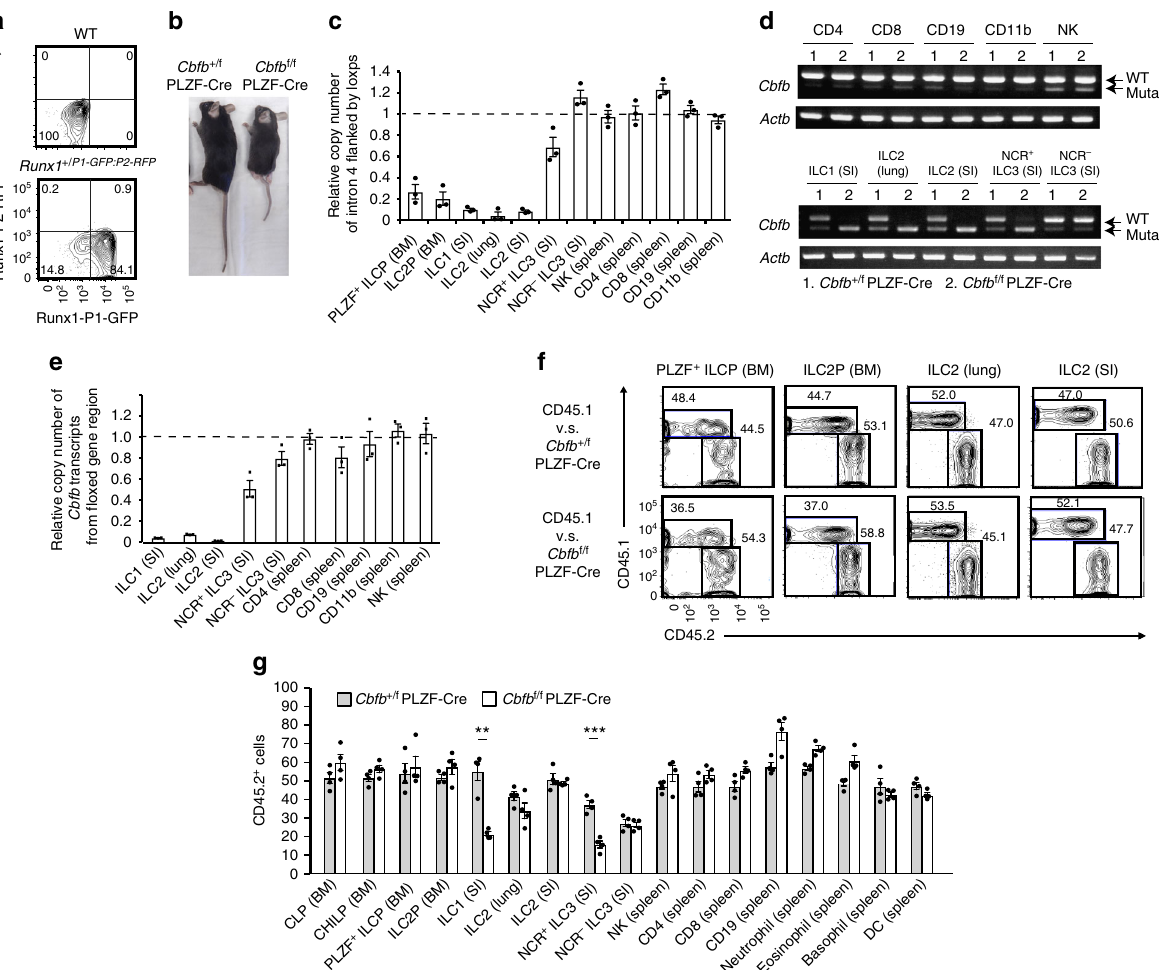
Fig. 1 Cbf β is not necessary for ILC2 differentiation. a Flow cytometry analysis of Runx1-GFP expression from the P1 promotor and Runx1-RFP from the P2 promotor by ILC2s (CD45 + CD3 – CD19 – CD127 + CD25 + ST2 + ) in the lungs of WT (top) and Runx1 + /P1-GFP: P2-RFP mice (bottom). b Gross appearance of the Cbfb + /f PLZF-Cre (left) and Cbfb f/f PLZF-Cre mice (right). c Quantitative PCR analysis of the relative copy numbers of the fl oxed genes (loxP site, loxps) located in Cbfb intron 4 compared to those of the un fl oxed genes in Cbfb intron 4 in the indicated cell populations of Cbfb f/f PLZF-Cre mice. d RT- PCR assay of Cbfb transcripts with or without a mutation in the indicated cell populations of the Cbfb + /f PLZF-Cre (1) and Cbfb f/f PLZF-Cre mice (2). e Quantitative PCR analysis of the relative copy numbers of Cbfb transcripts from the fl oxed Cbfb gene locus in the indicated cell populations of Cbfb f/f PLZF-Cre mice. f , g Chimerism of common lymphoid progenitor (CLP: CD45 + Lin – cKit lo CD127 + sca1 lo Flt3 + α 4 β 7 – ), CHILP (CD45 + Lin – CD127 + α 4 β 7 + Flt3 – CD25 – ), PLZF + ILCP (CD45 + Lin – cKit + CD127 + α 4 β 7 + PLZF-GFP + ), ILC2 precursor (ILC2P: CD45 + Lin – CD127 + α 4 β 7 + Flt3 – CD25 + ) cells, ILC1s